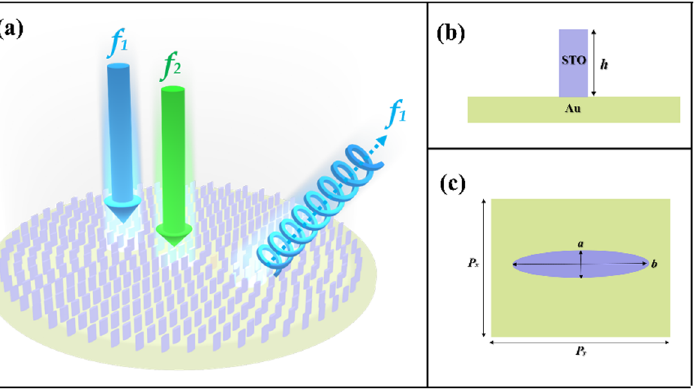
Figure 3. ( a ) The schematic diagram of the designed multifunctional meta-surface composed of the dielectric-metal hybrid single-layer antenna array. ( b ) Side view of the single-layer antenna. ( c ) Top view of the single-layer antenna.